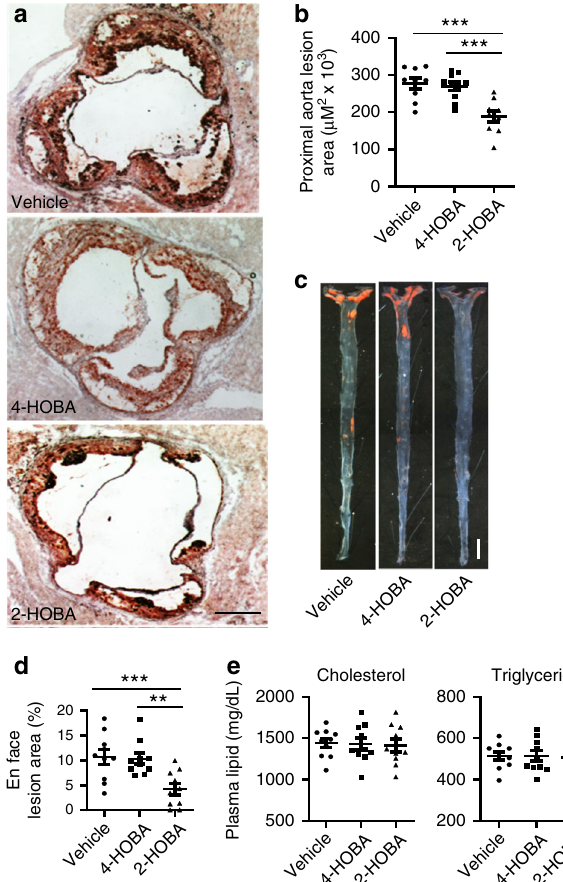
Fig. 1 2-HOBA attenuates atherosclerosis in hypercholesterolemic female Ldlr − / − mice. 8-week-old Ldlr − / − female mice were pretreated with 1 g/L 2-HOBA or 1 g/L 4-HOBA (nonreactive analog) or vehicle (water) for 2 weeks and then the treatment was continued for 16 weeks during which the mice were fed a Western diet. Representative images ( a ) and quantitation ( b ) of Oil-Red-O stained proximal aorta root sections. Scale bar = 500 µ m. n = 9 (vehicle), 10 (4-HOBA), or 9 (2-HOBA) biologically independent mice. Data are presented as mean ± SEM, One-way ANOVA with Bonferroni ’ s post hoc test, p values of 2-HOBA vs 4-HOBA and 2- HOBA vs vehicle are ***0.0009 and ***0.0004. Representative images ( c ) and quantitation ( d ) of Oil-Red-O stained open-pinned aortas. n = 10 biologically independent mice per group. Data are presented as mean ± SEM. One-way ANOVA with Bonferroni ’ s post hoc test, p values of 2- HOBA vs 4-HOBA and 2-HOBA vs vehicle are **0.0055 and **0.0033. e The plasma total cholesterol and triglyceride levels. n = 10 biologically independent mice per group. Data are presented as mean ± SEM. One-way ANOVA with Bonferroni ’ s post hoc test, p values of 2-HOBA vs 4-HOBA and 2-HOBA vs vehicle are >0.9999 for both cholesterol and triglyceride levels. Source data are provided as a source data fi